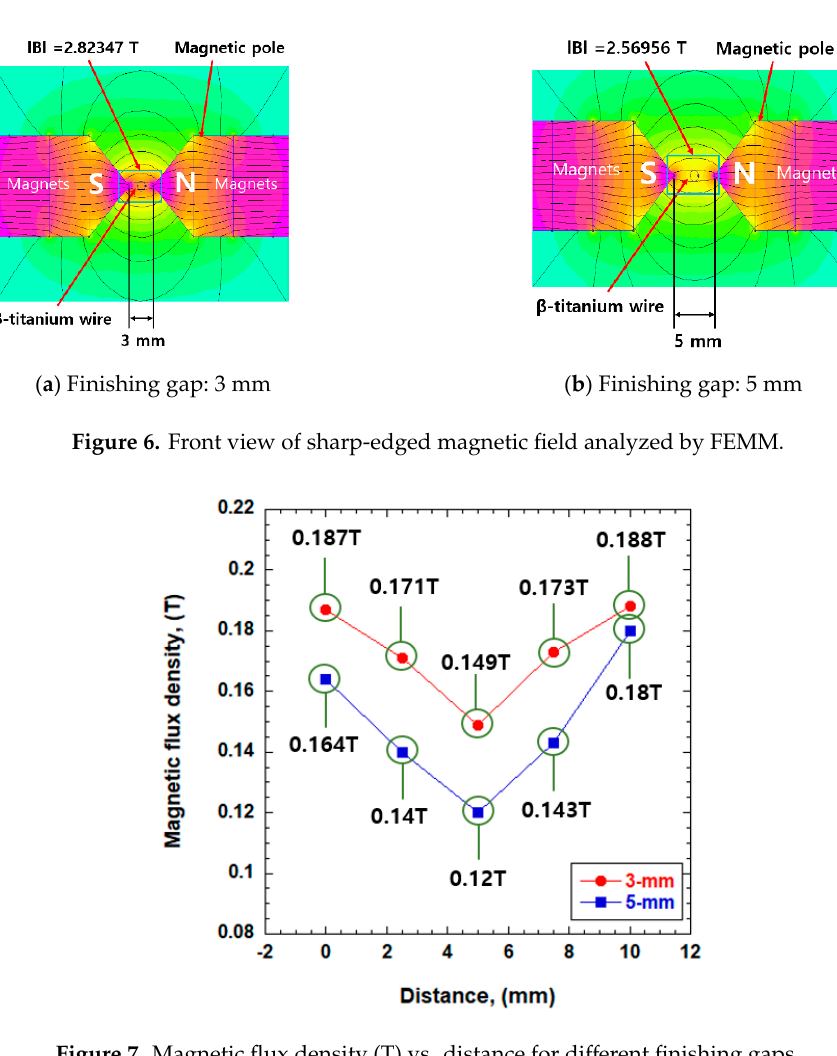
Figure 8. Surface roughness (Ra) vs. processing time for different finishing gaps (vibration: 8 Hz; abrasive: 1 μ m; rotation: 2000 rpm; sharp edge magnetic pole). The surface conditions of beta-titanium wire before and after finishing were investigated using an optical microscope (IMS-M-345) (see Figure 9). Figure 9a shows the initial surface condition before the finishing process. As shown in Figure 9a, the multiple grooves and original scratches can be found everywhere on the initial surface and surface roughness Ra is 0.32 μ m. Figure 9b shows the surface condition after the finishing process. From Figure 9b, the surface condition of beta-titanium wire is smoother than the initial surface condition and the multiple grooves were mostly removed. A surface roughness (Ra) after the finishing process is 0.05 μ m.